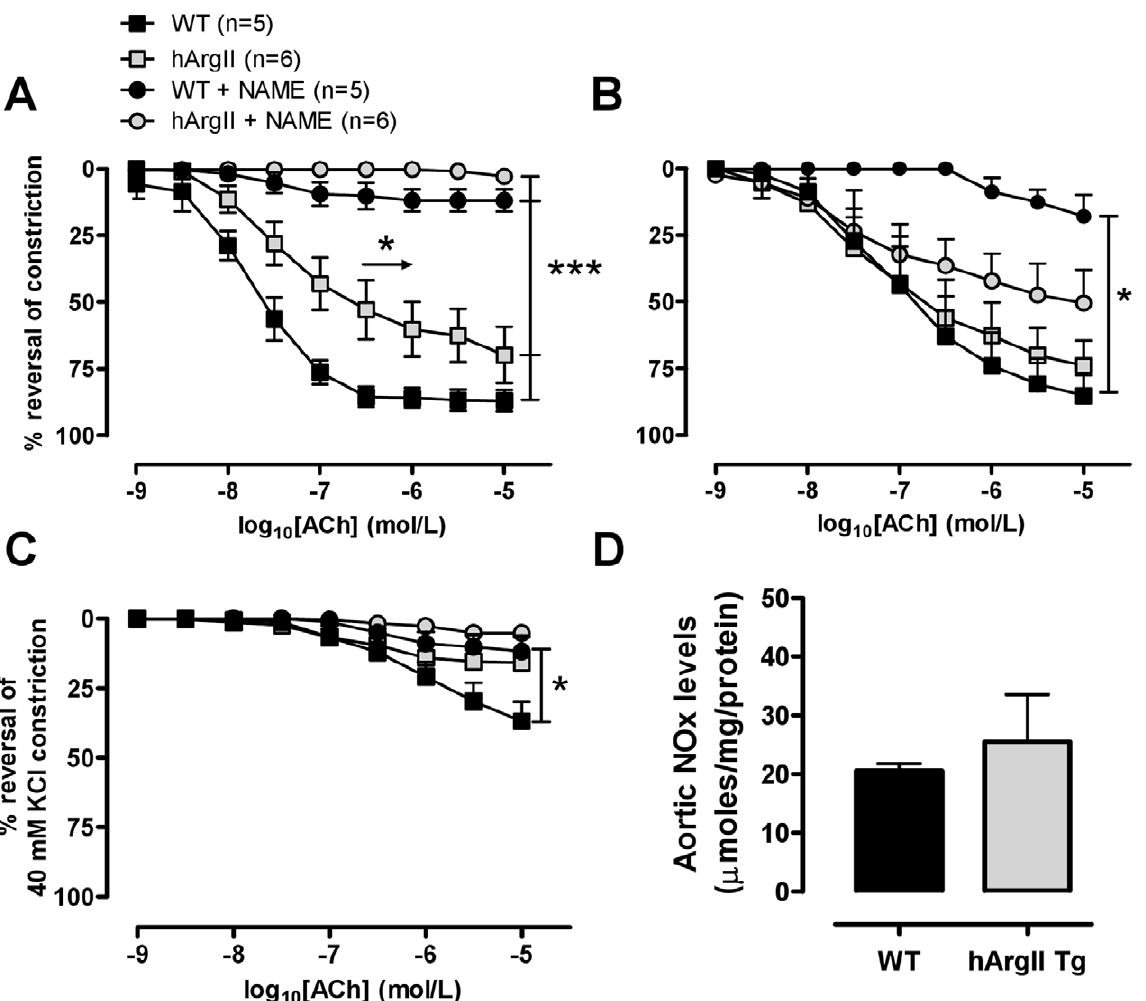
Figure 3. Concentration response curves to the endothelium-dependent vasodilator acetylcholine (ACh) before and after the addition of the nitric oxide synthase inhibitor NG-nitro-L-arginine methyl ester (NAME; 100 m mol/L) in A aorta constricted with cirazoline and mesenteric arteries constricted with B cirazoline or C high potassium from male homozygous hArgII Line 11 mice (n=4 2 6) and their WT littermate controls (WT; n=5 2 6). D NO production as determined by measuring NOx (nitrate and nitrate) using the Griess reaction in homogenized aorta and normalized to protein concentration in aorta from homozygous hArgII line 11 males and littermate non- transgenic control males (n=8 2 9). Data are presented as mean 6 SEM. EC 50 and E max values were compared using 1-way ANOVA with Bonferroni posthoc test, where *= P , 0.05 and ***= P , 0.001.